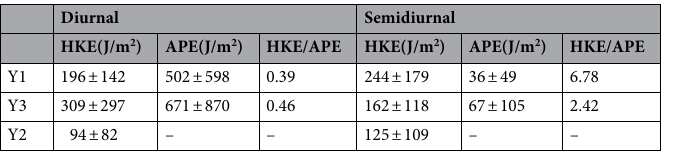
Table 3. Time-averaged diurnal and semidiurnal HKE, APE and HKE/APE ratio at the three moorings.